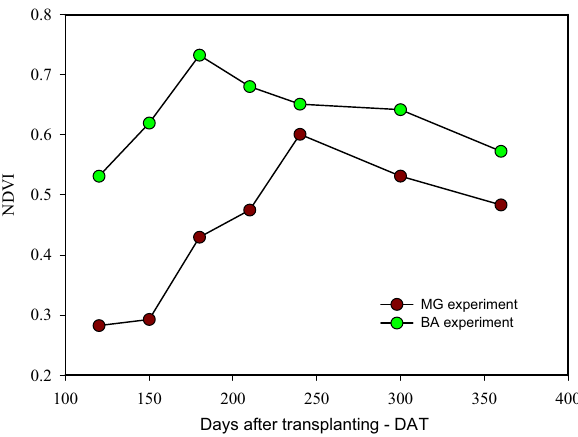
Figure 9. Mean NDVI values from Sentinel 2 for MG experiment and BA experiment.